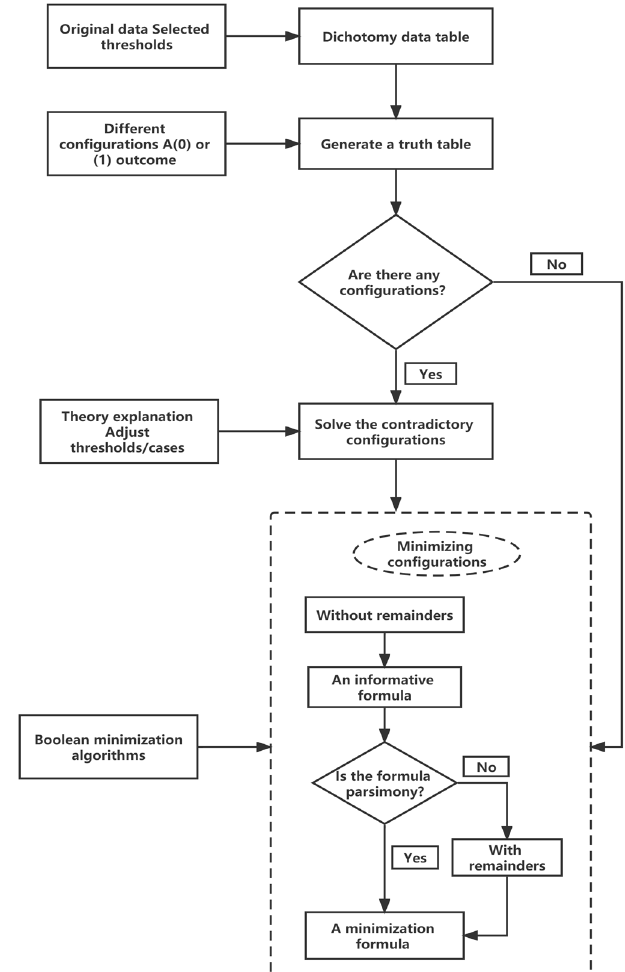
Figure 2. Qualitative comparative analysis procedure.